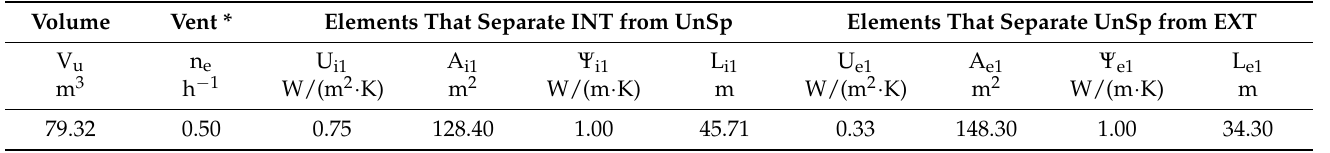
Table 13. Geometric and physical characteristics of the Attic